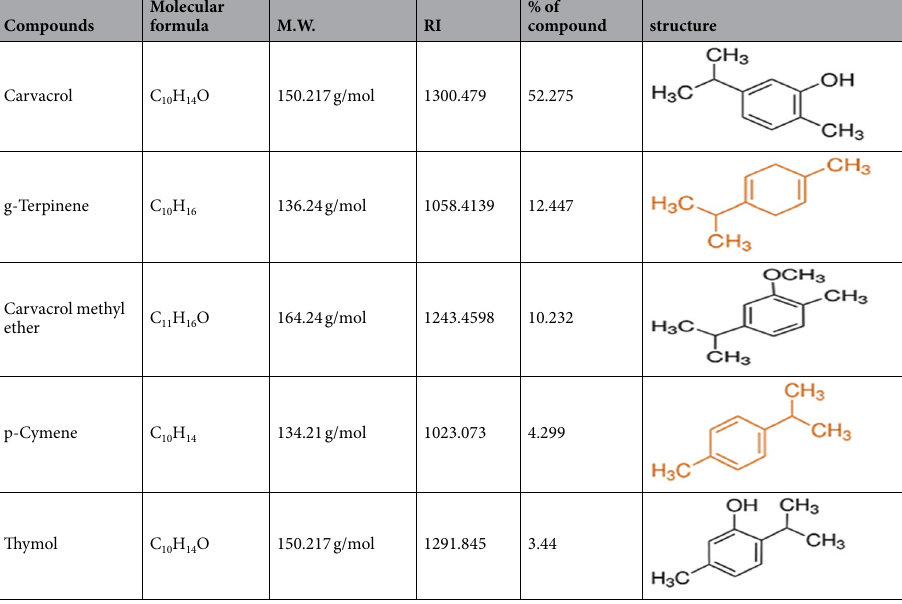
Table 1. List of major compounds present in ZEO analyzed by GC-MS. ZEO main components, their structures, Molecular Weights (M.W.) and Retention Indices (RI) are listed.